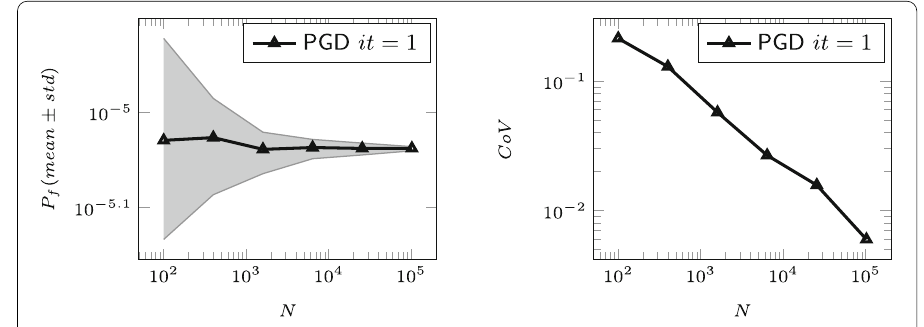
Fig. 12 Cross-section: convergence of failure probability (left) and its standard deviation (right) over the number of samples N running itPGDrel-PF for it = 1 (50 runs, p 0 = 0 . 1, N p = 100, N max = 102 , 400 and ξ = 10)